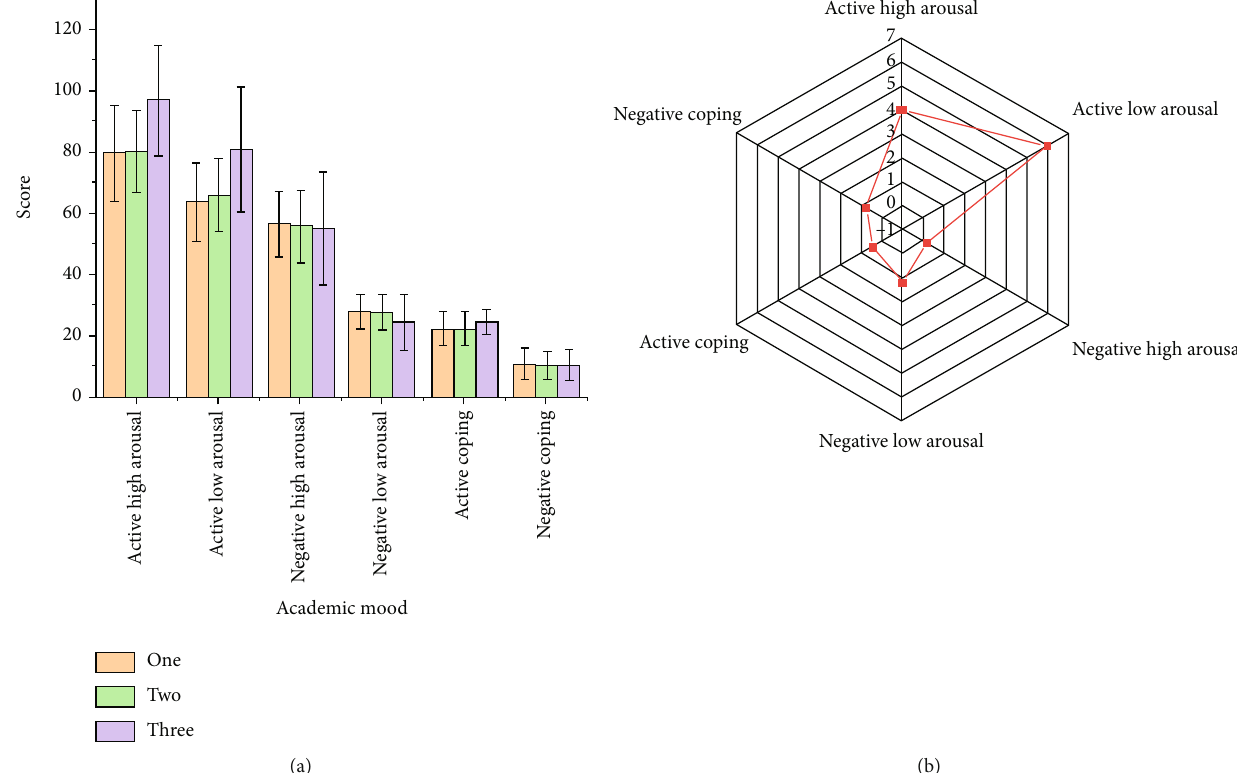
Figure 9: Di ff erences in academic emotions and coping styles of art students in di ff erent grades ((a) score statistics for each dimension and (b) one-way analysis of variance for each